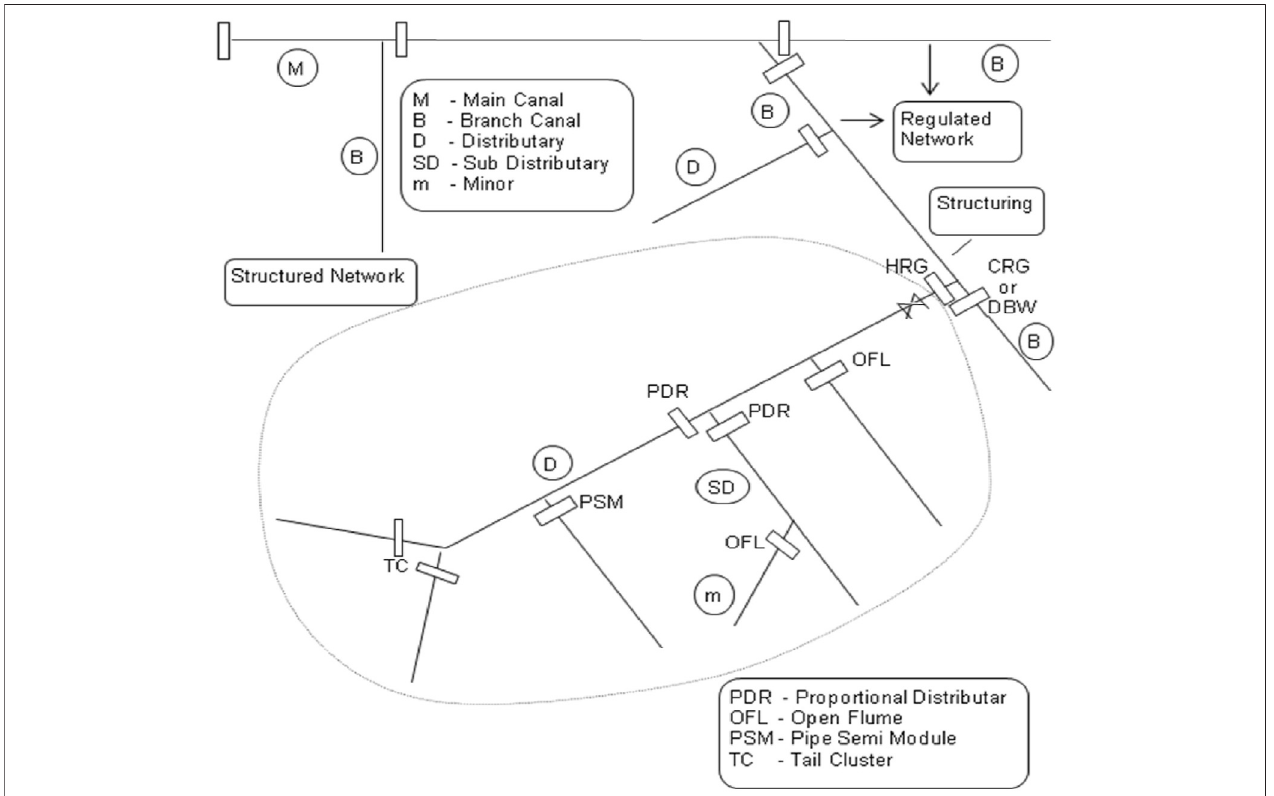
FIGURE 1 | Schematic of a structured irrigation